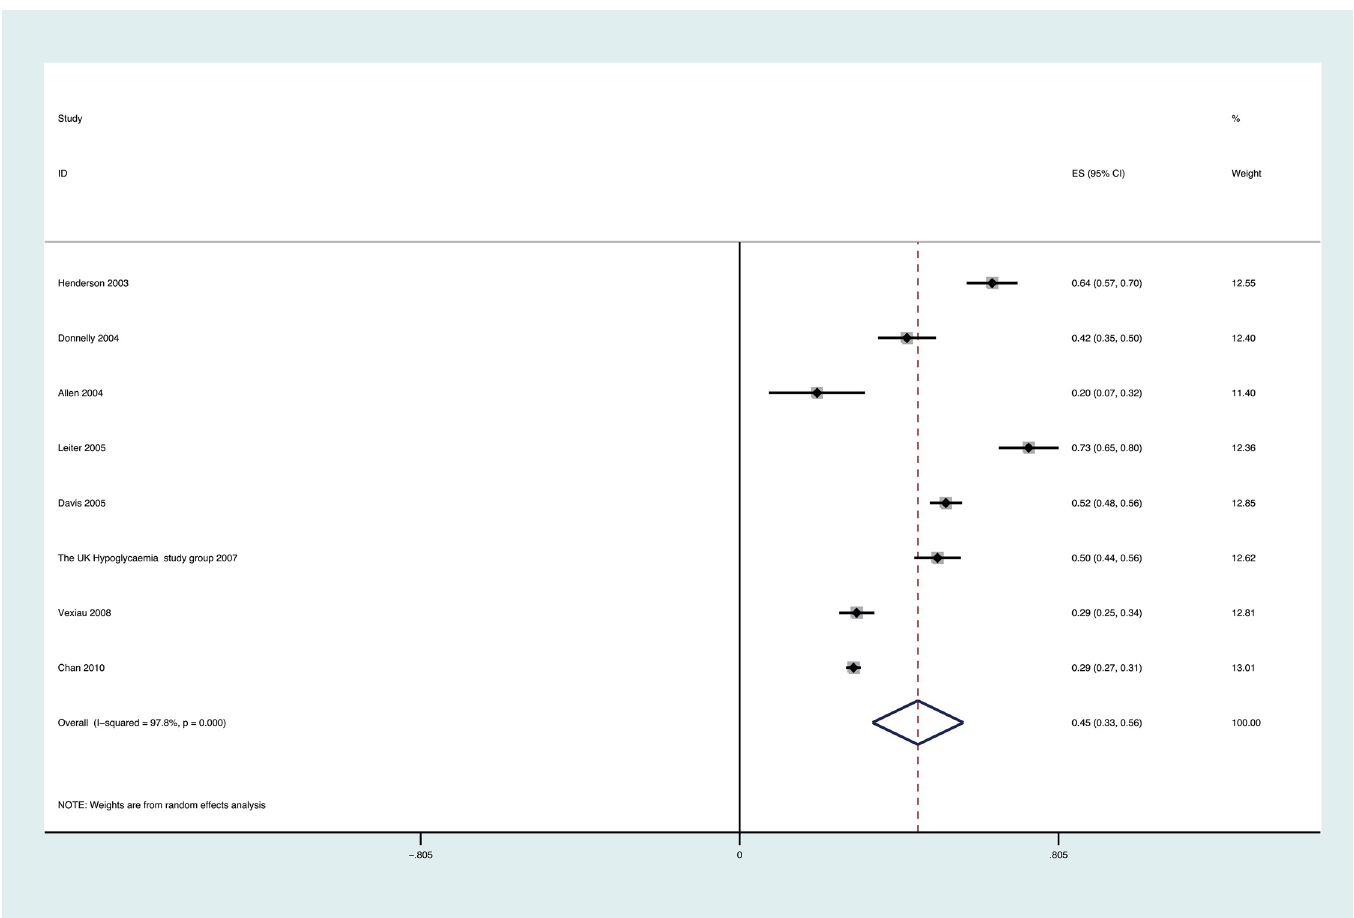
Fig 2. Forest plot showing the proportion of people experiencing mild/moderate hypoglycaemia in each study and the overall pooled estimate. Boxes and horizontal lines represent proportion of people experiencing unspecified hypoglycaemia and the corresponding 95% CI, respectively, for each study. Size of box is proportional to weight of that study result. Diamonds represent the 95% CI for pooled estimates of effect and are centred on pooled hypoglycaemia incidence.